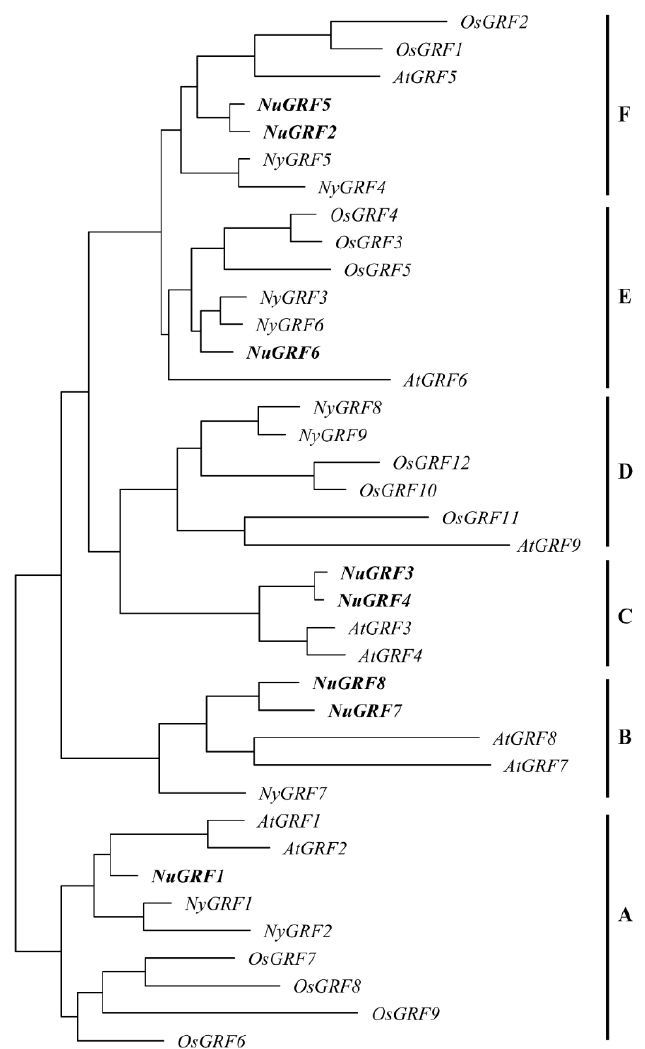
Figure 1. Phylogenomic tree of GRF genes. The genes beginning with “Nu” represent the genes of N. nucifera , “Os” represents the genes of rice, “Ny” represents the genes of Ny. colorata , and “At” represents the genes of A. thaliana. “A” represents Clade A, “B” represents Clade B, “C” represents Clade C, “D” represents Clade D, “E” represents Clade E, “F” represents Clade F.